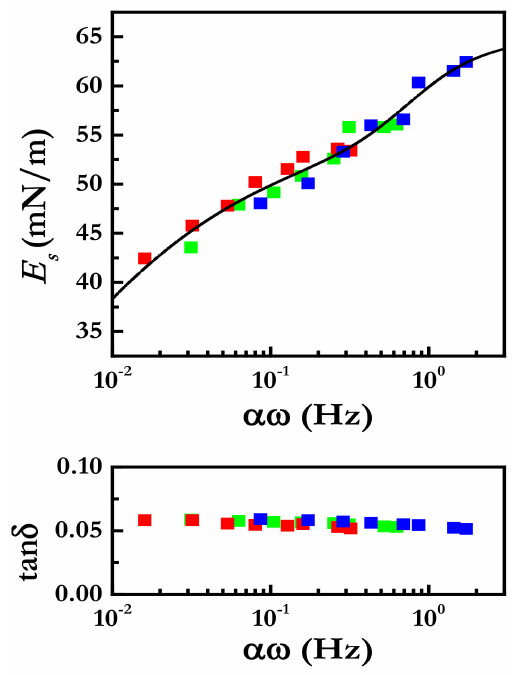
Figure 5. Re-scaled frequency dependences of the elastic modulus and loss tangent for chitosan- anionic surfactant mixtures with different surfactant concentrations (symbols of different color represents the set of data for solutions with different concentrations) and a fixed chitosan concentra- tion of 2 g/L (pH 4.5 and ionic strength 120 mM NaCl). The symbols are the experimental results, and the solid lines represent the best fit of the experimental curves to a model, including a Lucassen-Van der Tempel-like relaxation process and a relaxation process affecting the interface. Adapted from Akanno et al. [51], with permission from Royal Society of Chemistry, Copyright